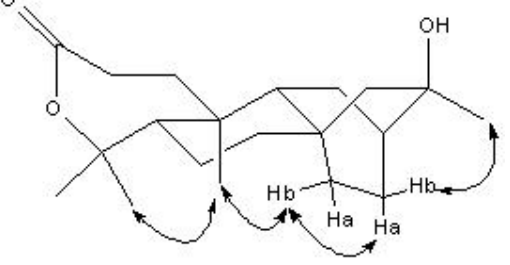
Figure 3. The key NOE correlations of compound 4 .